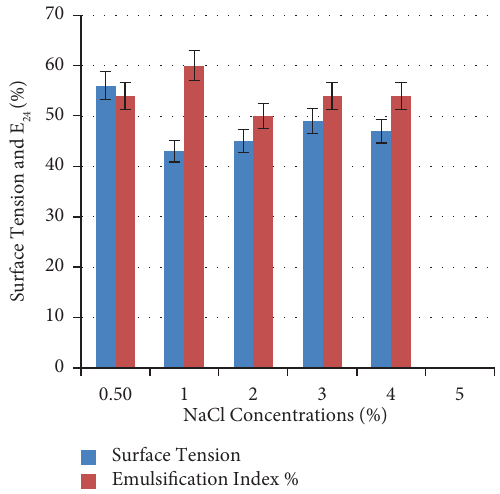
Figure 11: Efect of NaCl concentrations on biosurfactant pro- duction. A maximum E 24 % (54 ± 0.33%) and minimum surface tension (55 ± 0.33mN/m) were obtained at 1% (w/v) NaCl.